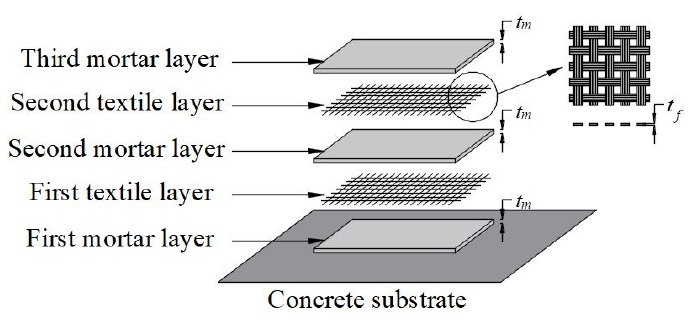
Figure 2. Schematic representation of typical TRM system.